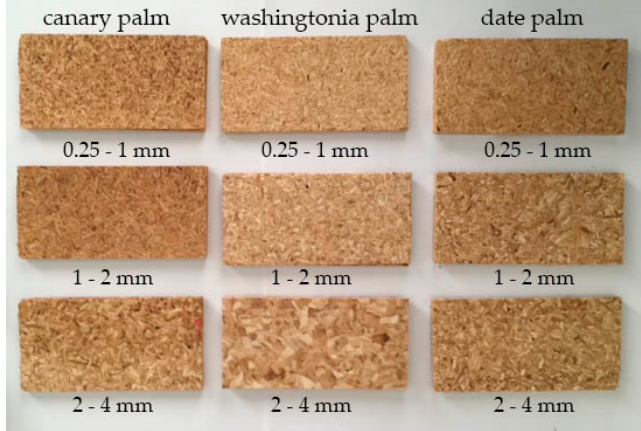
Figure 2. Particleboards made with rachises of different palm species.